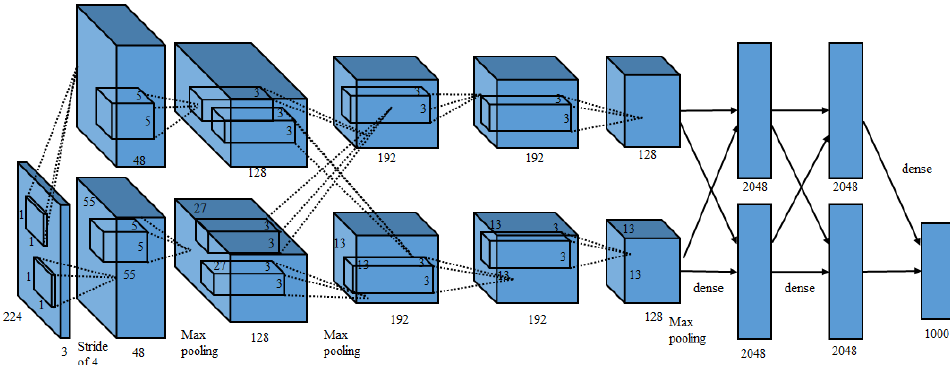
Figure 7. The flowchart for AlexNet.